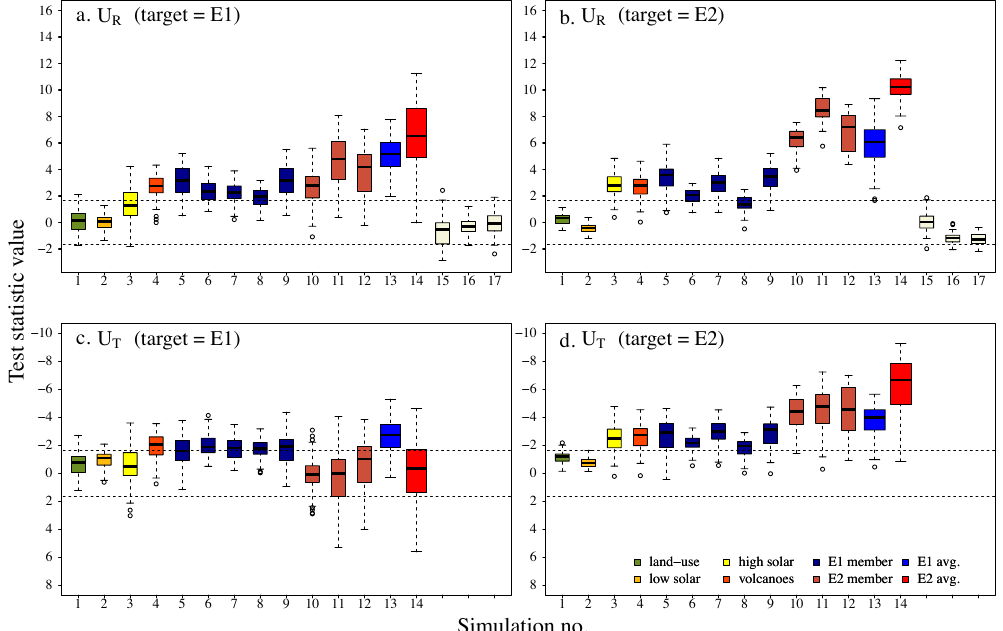
Fig. 3. Box plots for U R correlation (top panel) and U T distance (bottom panel) test statistics for each of the global land-only average COSMOS simulation temperature series, compared to ≈ 100 different pseudo-proxy temperature realizations (iteratively running through the E1 and E2 ensemble members as targets – see text). The left panels are for E1 (“low” solar) as target, right E2 (“high” solar) as target. The 5% two-sided significance levels are shown with dashed lines. Each box covers the 50% interval between the lower and upper quartiles, with the median as a thick black line between. The simulations are: 1=land-use changes, 2=low solar, 3=high solar, 4=volcanoes, 5– 9=E1, 10–12=E2, 13=average E1, 14=average E2. The CTRL simulation (numbers 15–17) results are shown for the U R analysis but not for U T , since they are then used as internal references. Note that the y-axis for U T is flipped to simplify any comparisons with the U R box